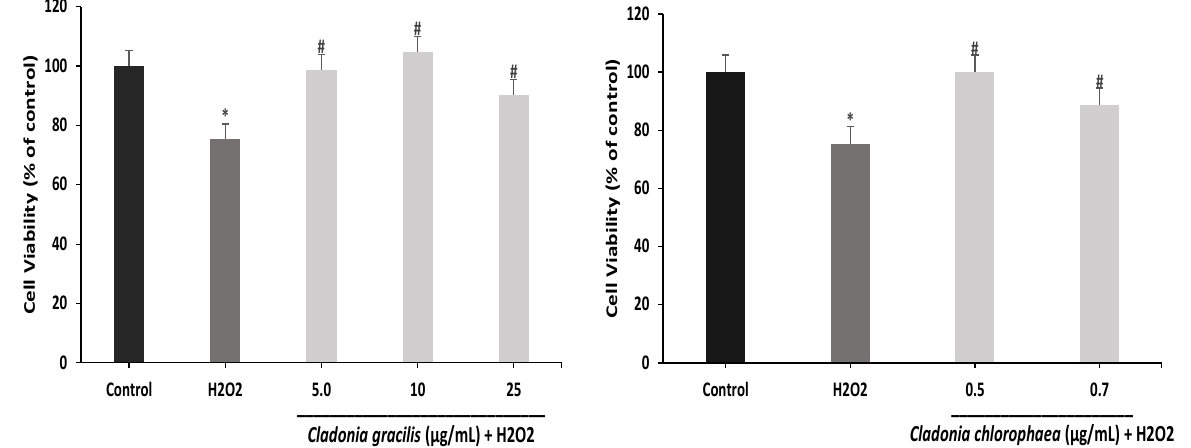
Figure 8. Effect of C. gracilis and C. chlorophaea extracts on viability in the SH-SY5Y cell line. The values represent the means ± SD of three replicates (n = 3).